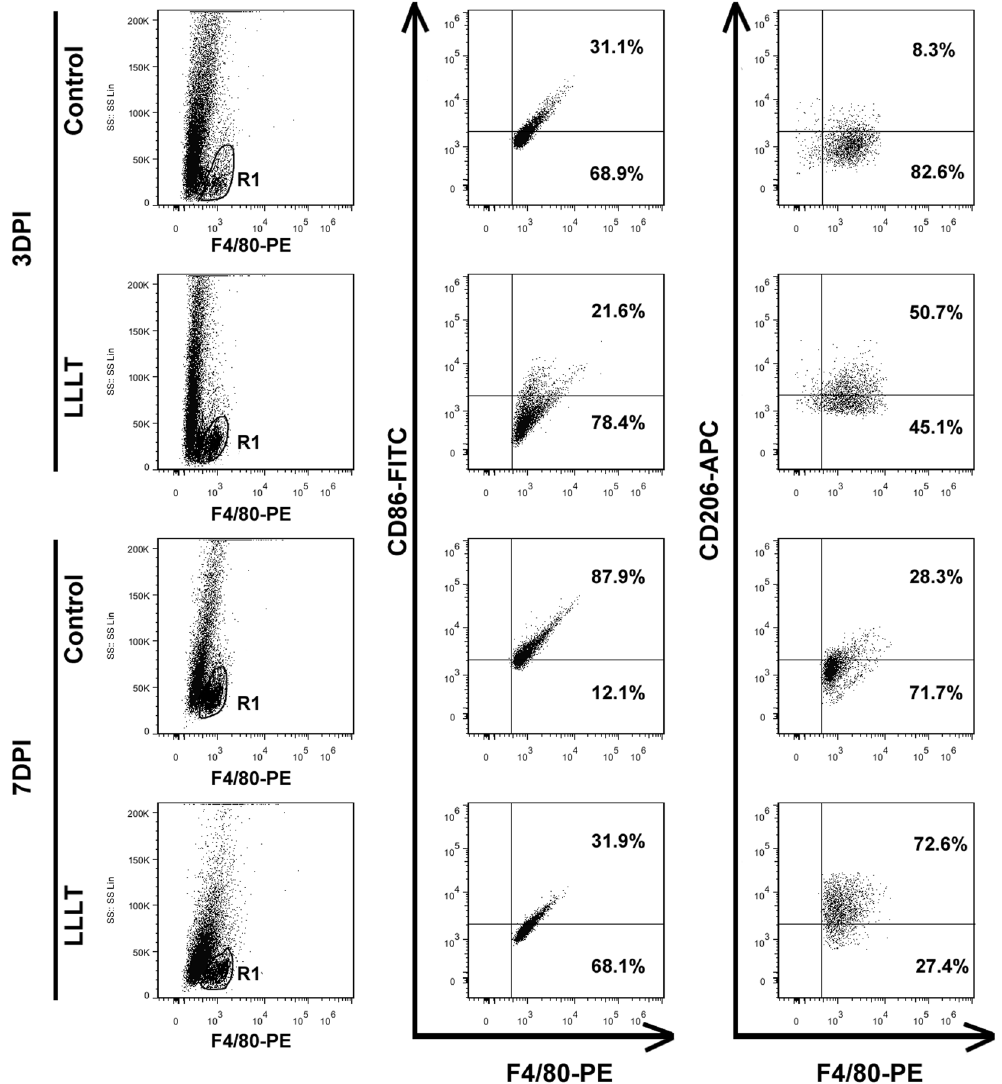
Figure 3. Dot plot of macrophage/microglia subpopulations. Representative dot plot of M1 and M2 subpopulations. R1 regions were gated as F4/80-positive populations. M1 cells were labelled with F4/80 and CD86, M2 cells were labelled with F4/80 and CD206. 3 dpi and 7 dpi refer to 3 and 7 days post-injury, respectively. SS, side